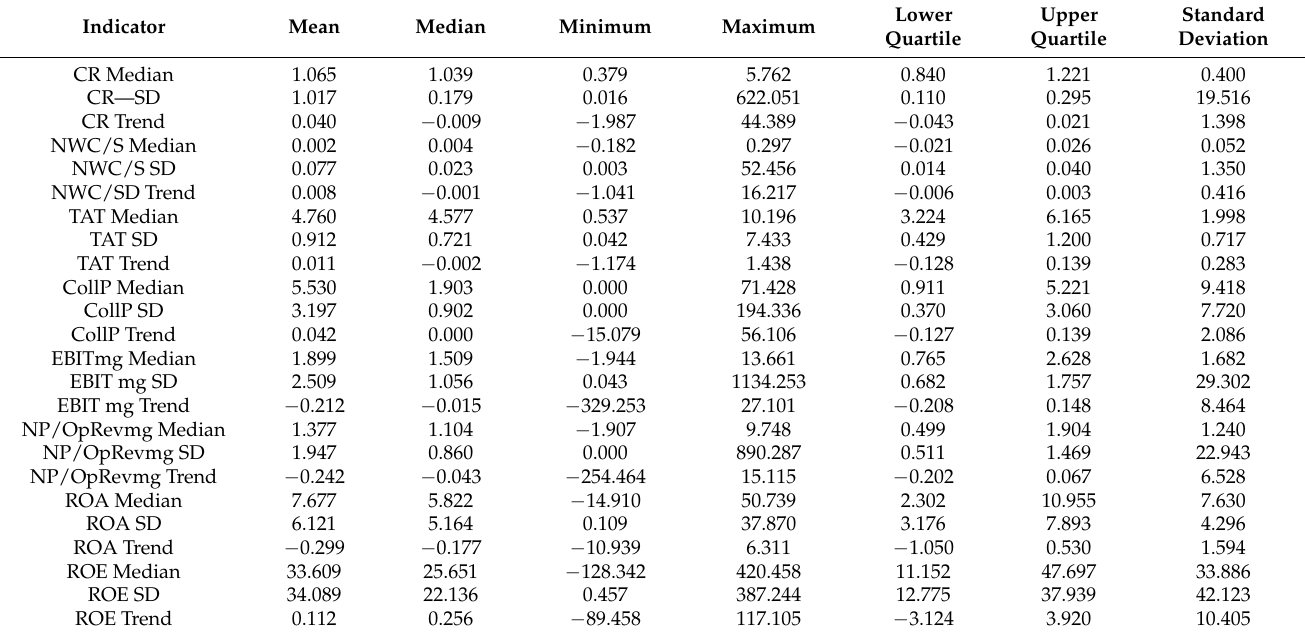
Table A3. Descriptive statistics of liquidity, efficiency, profitability, and aggregate performance indicators for high solvency risk companies, 2011–2019.